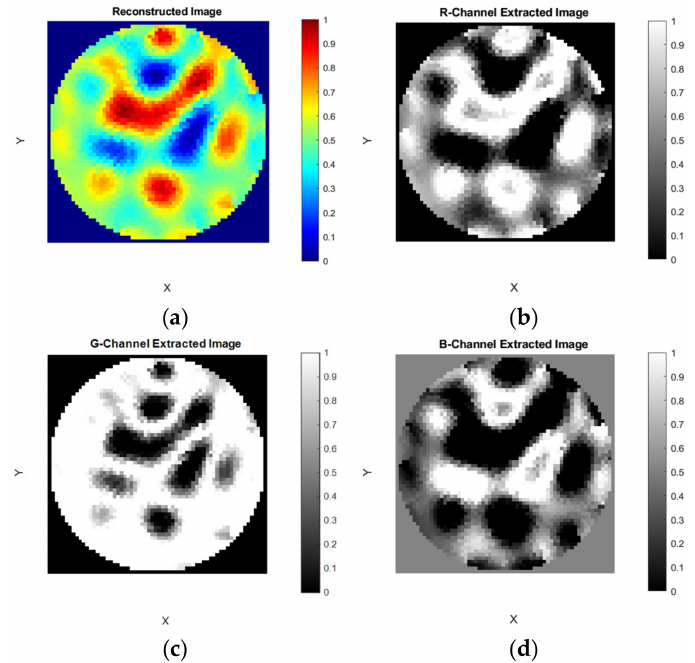
Figure 11. Visualization module: Color channel extraction and visualization subfigure ( a ) recon- structed image; ( b ) R-Channel image; ( c ) G-Channel image; ( d ) B-Channel